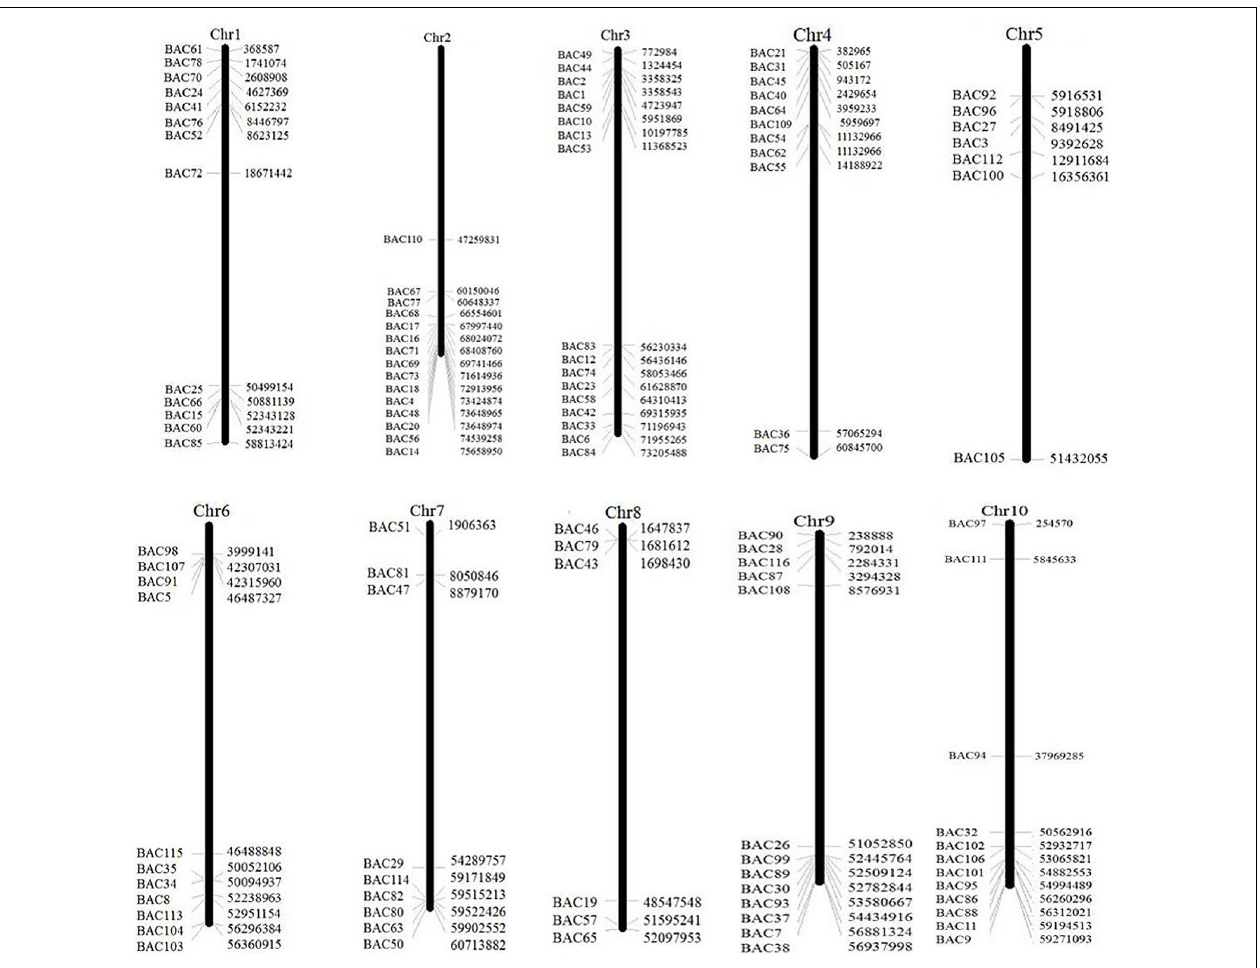
FIGURE 1 | The distributions of 114 BAC clones from AP85-441 in the chromosomes of sorghum. BAC1-114 represents the BAC number, the data on the right are the physical location of BAC in corresponding, region of the sorghum chromosomes. Unit = bp.